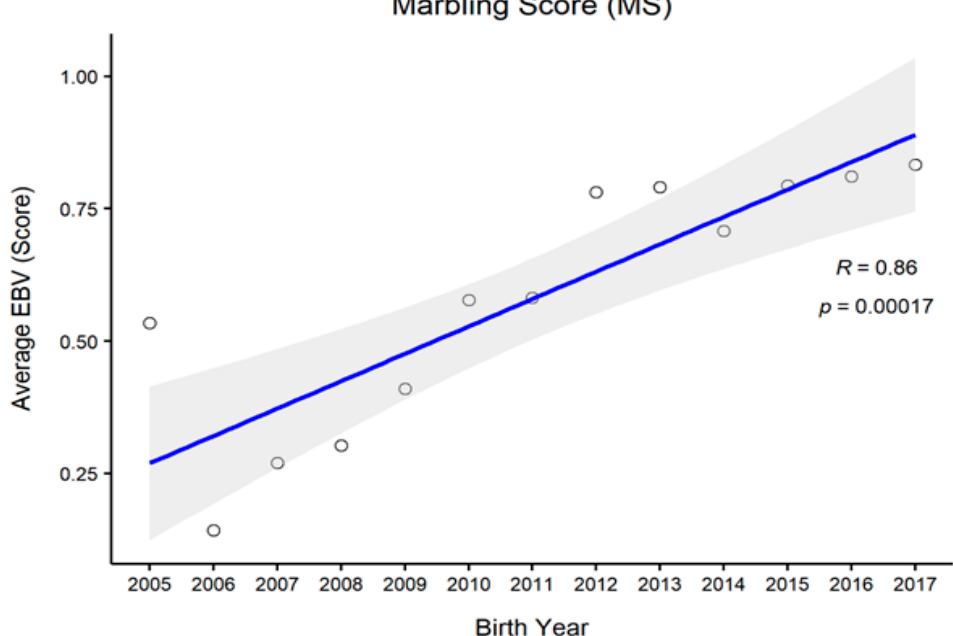
Figure 3. The genetic trend of estimated breeding values (EBVs) of backfat thickness of Hanwoo males from the 30-month production system (R, Pearson’s correlation coefficient; p , the p -value of correlation coefficients).